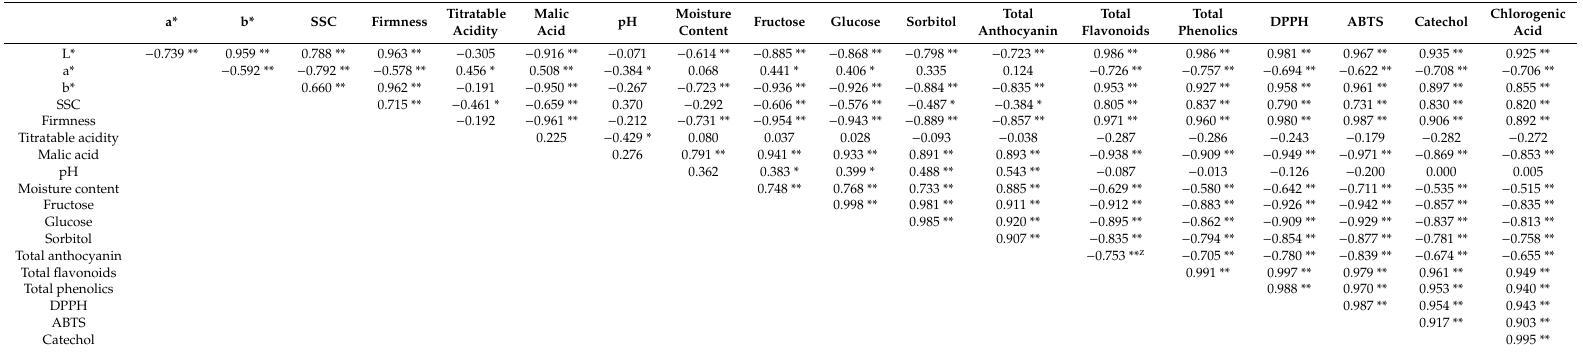
Table 5. Pearson correlation among physicochemical qualities, antioxidant compounds, and activities of Aronia melanocarpa fruits.